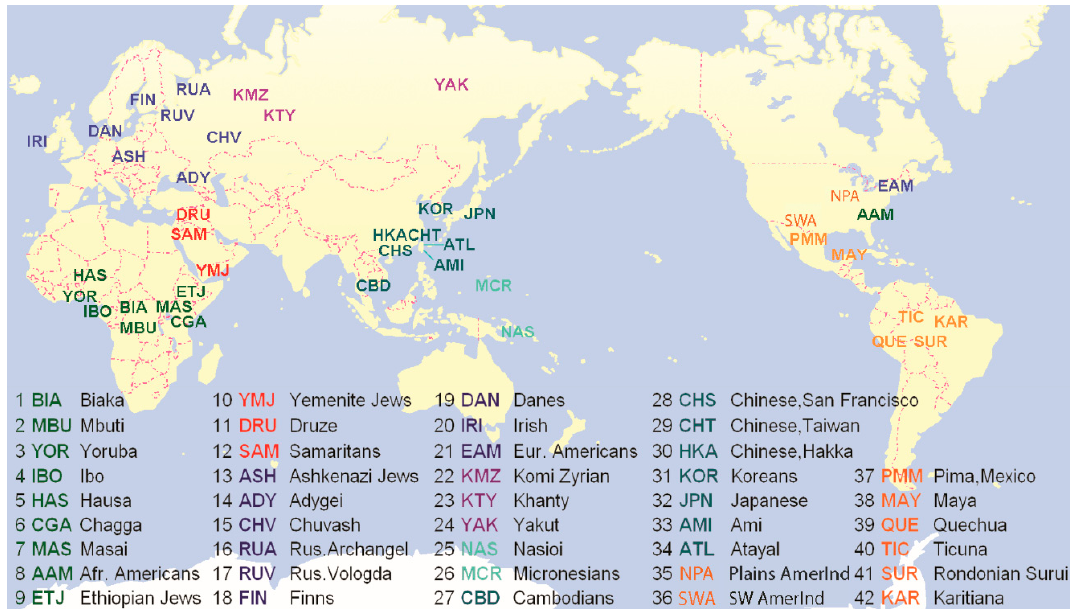
Figure 1. All 42 populations used in this study. Populations are geographically categorized and colored into eight groups: Africa (BIA, MBU, YOR, IBO, HAS, CGA, MAS, AAM, and ETJ), Southwest Asia (YMJ, DRU, and SAM), Europe (ASH, ADY, CHV, RUA, RUV, FIN, DAN, IRI, and EAM), Siberia (KMZ, KTY, and YAK), Pacific Islands (NAS and MCR), East Asia (CBD, CHS, CHT, HKA, KOR, JPN, AMI, and ATL), North America (NPA, SWA, PMM, and MAY,) and South America (QUE, TIC, SUR, and KAR). The three-character population symbols and corresponding full names are listed in pairs.